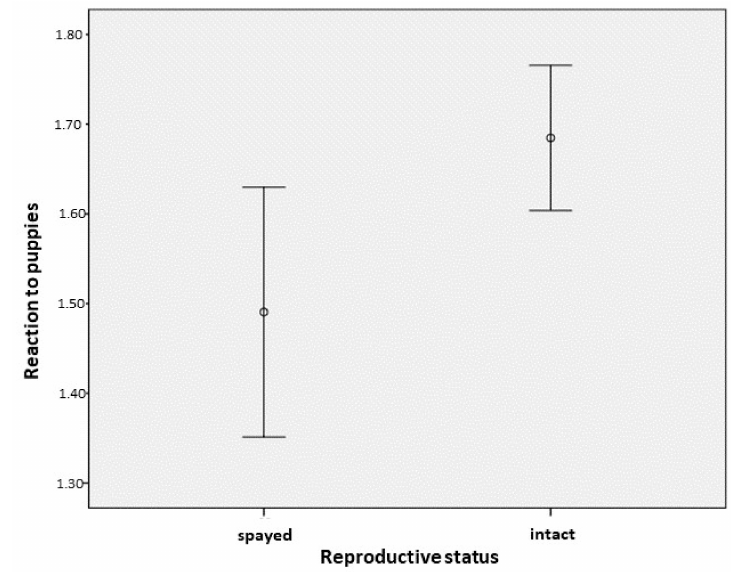
Figure 4. The association between the amicable reaction (mean ± 95% CI) of female dogs to puppies as a function of their reproductive status (0 = spayed, 1 =